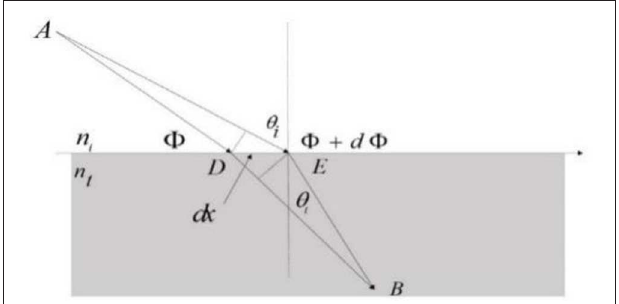
FIGURE 1 | Refraction with the phase